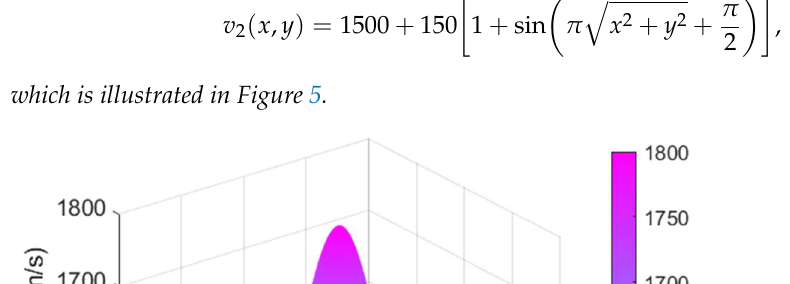
Figure 4. Absolute errors of the SBM–KS and the COMSOL Multiphysics finite element methods.